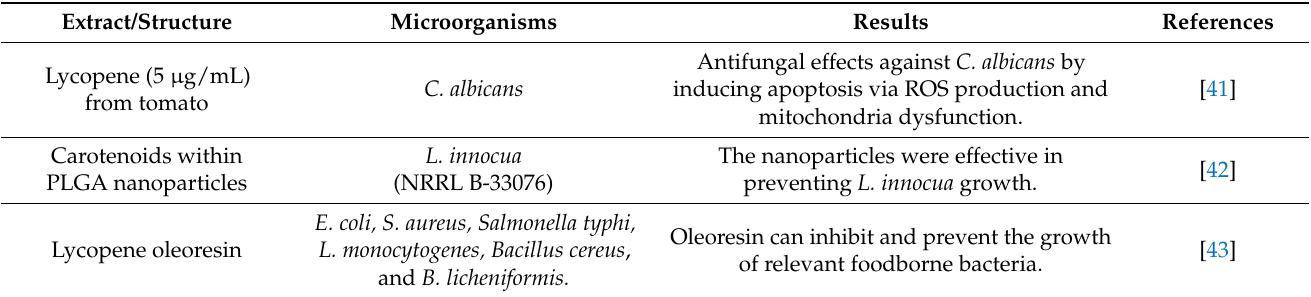
Table 3. Antimicrobial activity of lycopene or lycopene extracts from 2015 to 2021. Extract/Structure Microorganisms